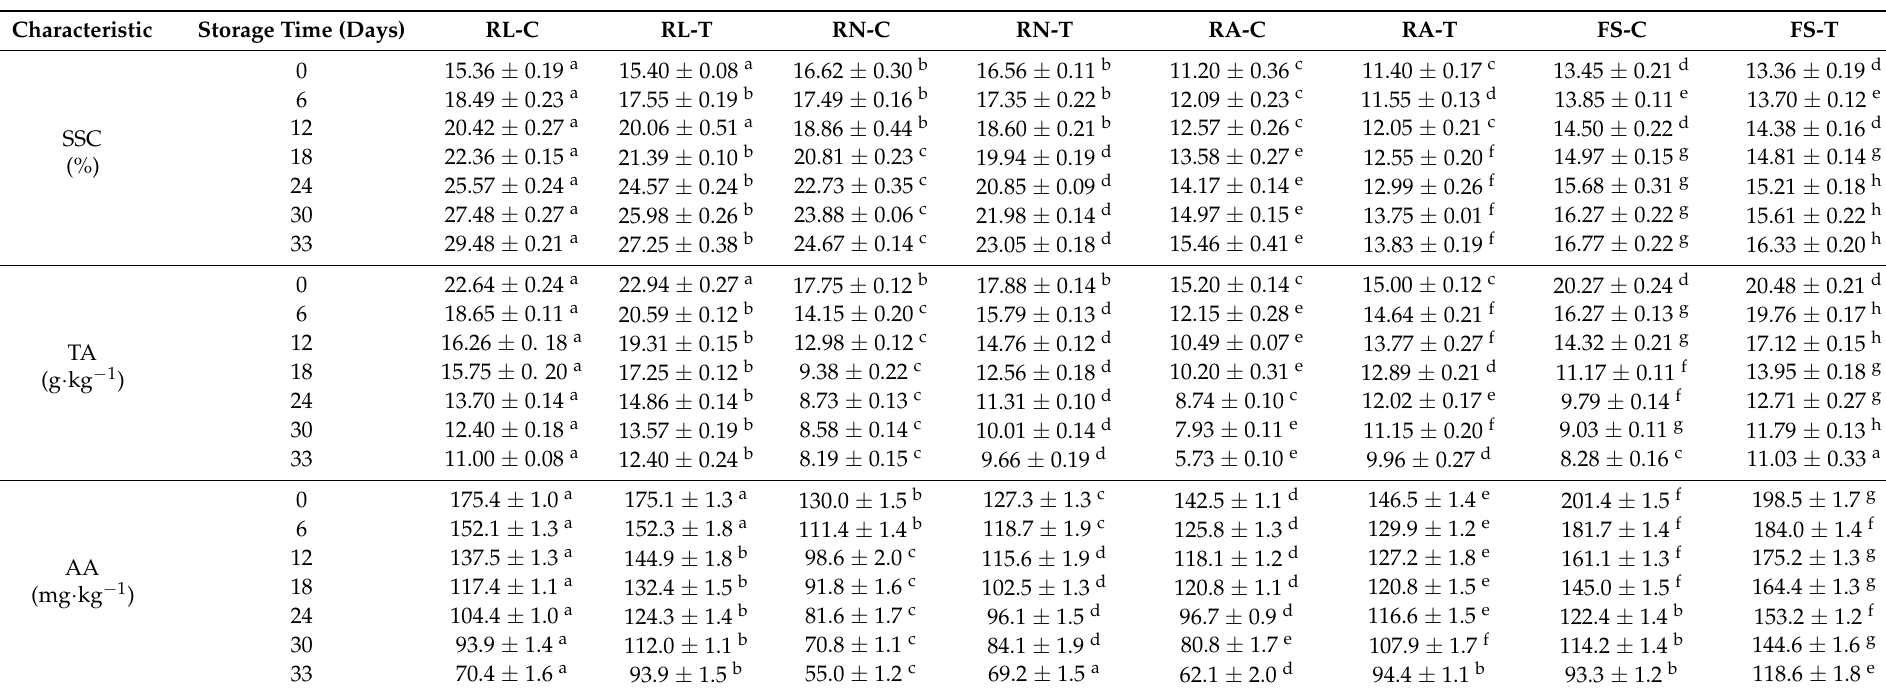
Table 7. Mean values for the nutritional parameters: Soluble Solids Content (SSC), Titratable Acidity (TA), and Ascorbic Acid (AA) content at harvest (0) and after 6, 12, 18, 24, 30, and 33 days storage for control and AA-CaCl 2 -CMCS-GL coated